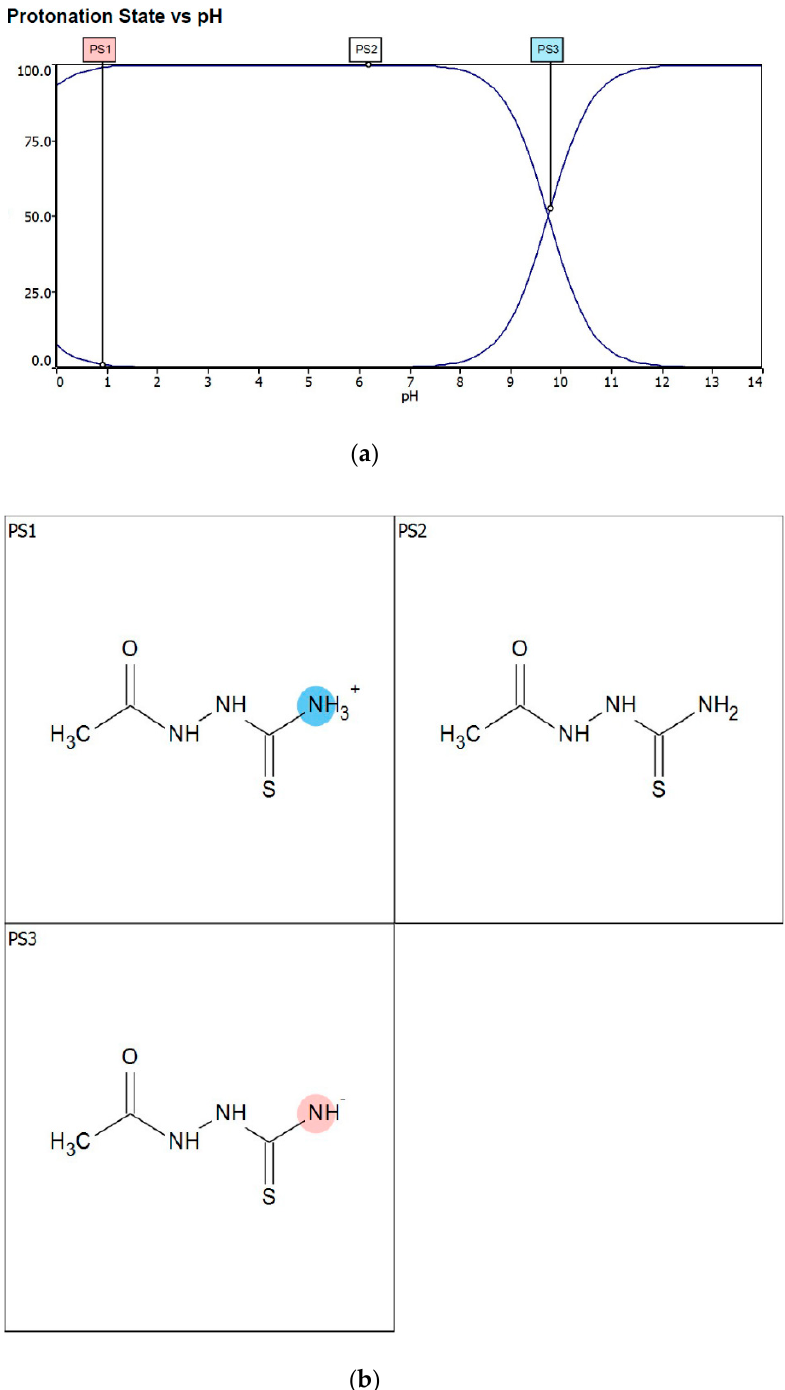
Figure 3. ( a ) The protonation process of AST molecules at different pH values and ( b ) the percentage of the three different microspecies at different pH values. At pH = 0, approximately 95% of AST exists in state PS2 and 0.5% in state PS1.